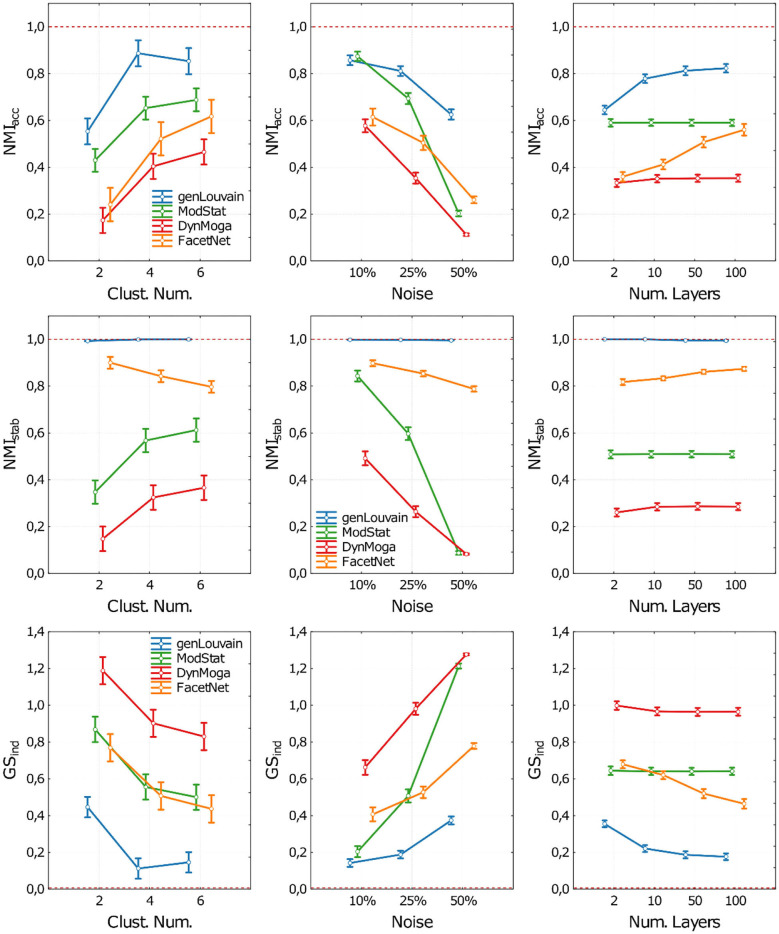
Plot of means and standard deviations of the three indices used to execute the comparative analysis on networks with stationary community structure. Each row of the figure corresponds to one index (NMIacc, NMIstab, GSind). For each index we report three panels where we show the algorithms' performances with respect to the Clusters Number (first column), Noise level (second column), and number of network's layer (third column). Algorithms are identified through a color code (blue-genLouvain, green-ModStat, red-DynMoga, orange-FacetNet). In each panel we can see how the performance of the algorithms varies according the values the ANOVA factors and which algorithm reaches highest performances, in terms of accuracy (NMIacc), stability (NMIstab) or both (GSind). The optimal performances are indicated though a red dotted line.